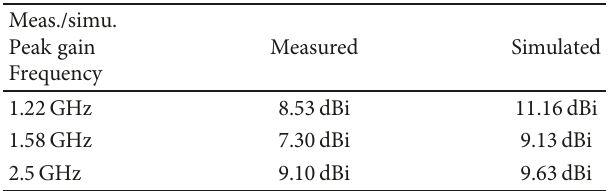
Table 5: Peak gain of measured and simulated radomes at selected